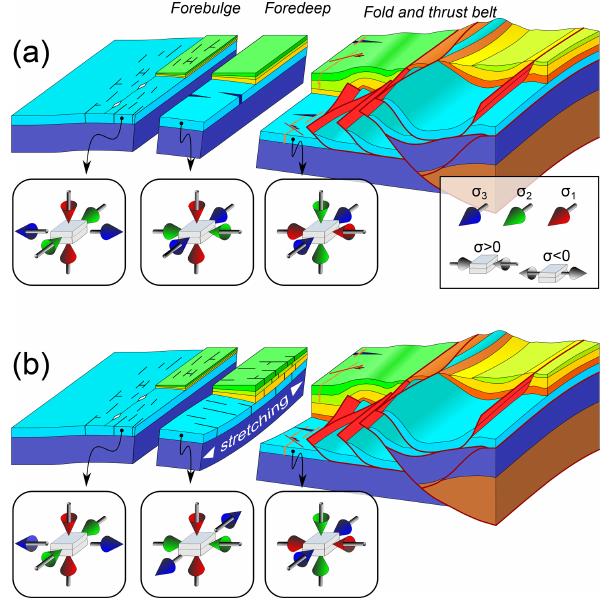
Figure 1. Scheme showing the architecture of a foreland fold-and- thrust belt and adjacent foredeep basin with synorogenic fracture patterns in the different structural domains of the orogenic system. (a) The foredeep state of stress is governed by the permutation be- tween the state of stress in the layer-parallel shortening and periph- eral bulge domains. (b) The foredeep state of stress is controlled by the along-strike stretching of the